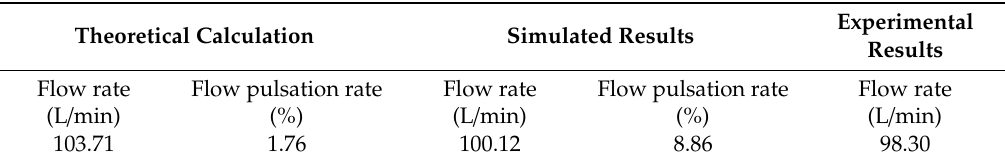
Table 6. Flow characteristics under no-load conditions.